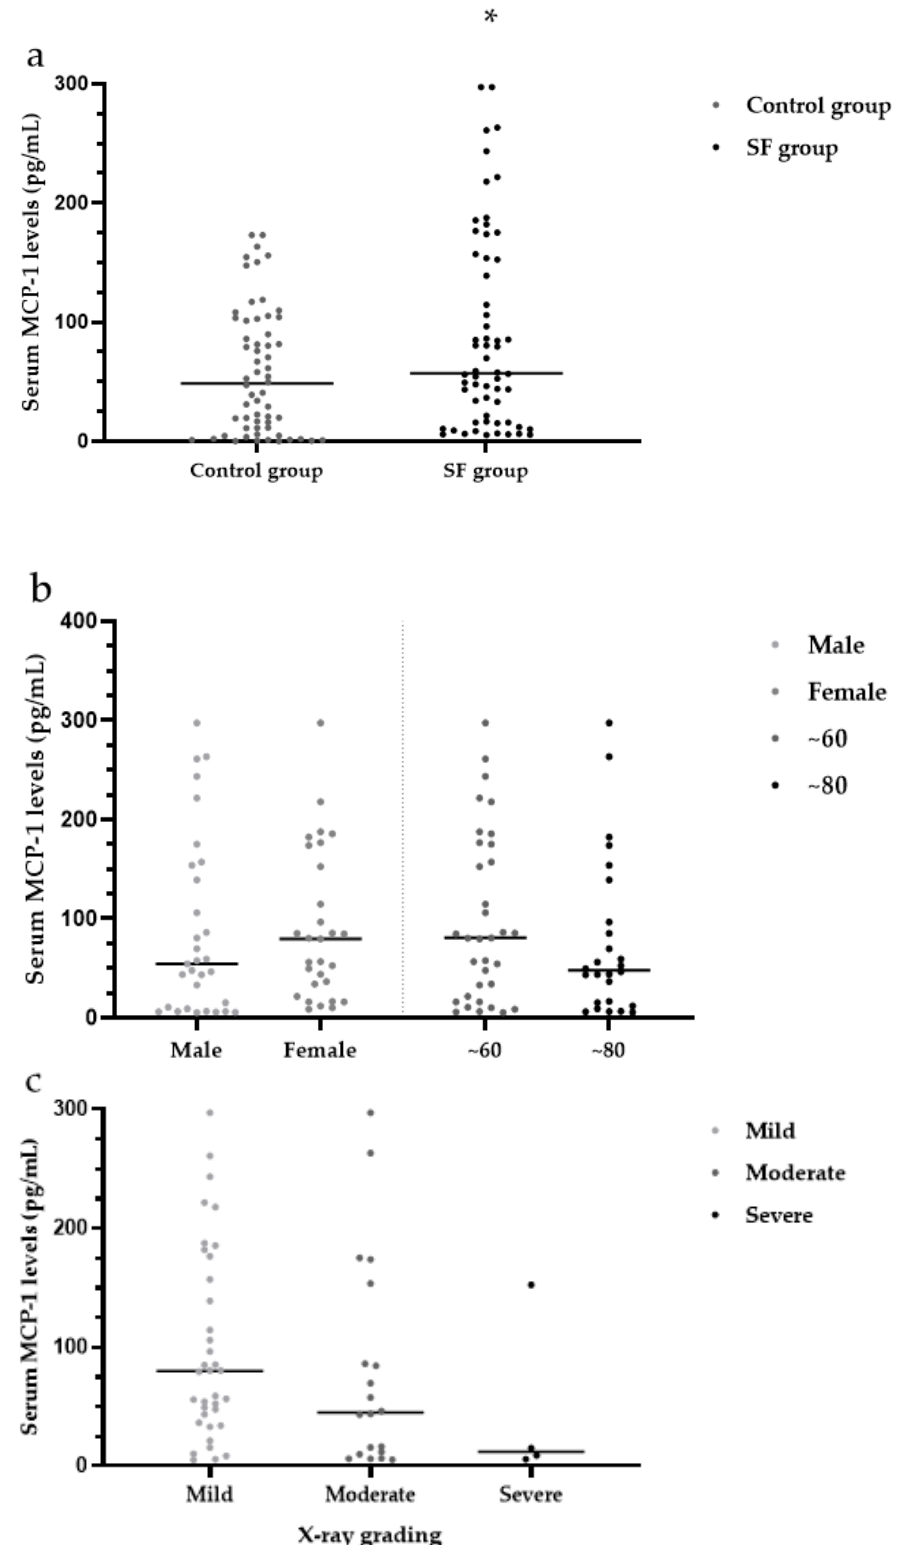
Figure 6. ( a ) Analysis of serum MCP-1 levels in the SF group and control group; ( b ) Analysis of MCP-1 levels in the SF group by sex and age; ( c ) Analysis of MCP-1 levels in the SF group by X-ray diagnostic grade. * p < 0.05 compared to the control group. MCP-1: monocyte chemoattractant pro- tein-1.